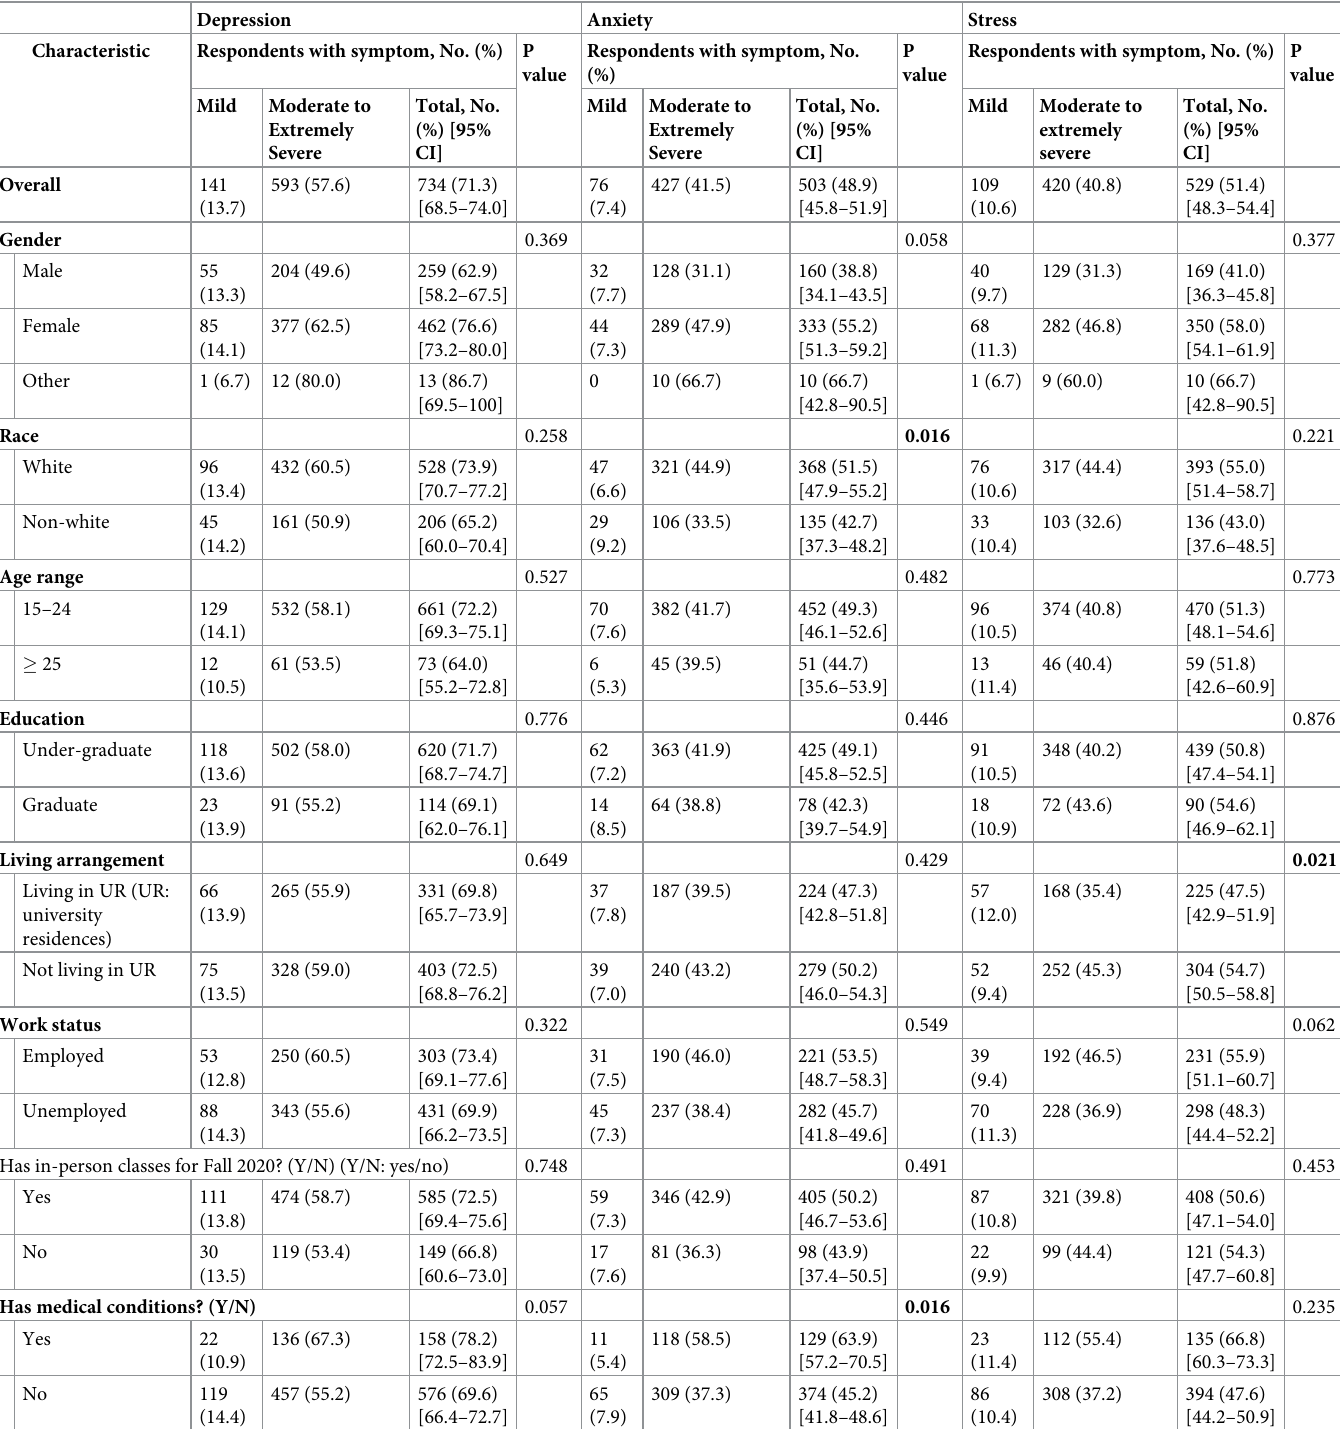
Table 2. Prevalence of symptoms of depression, anxiety, and stress (DASS-21) stratified by survey respondent characteristics.